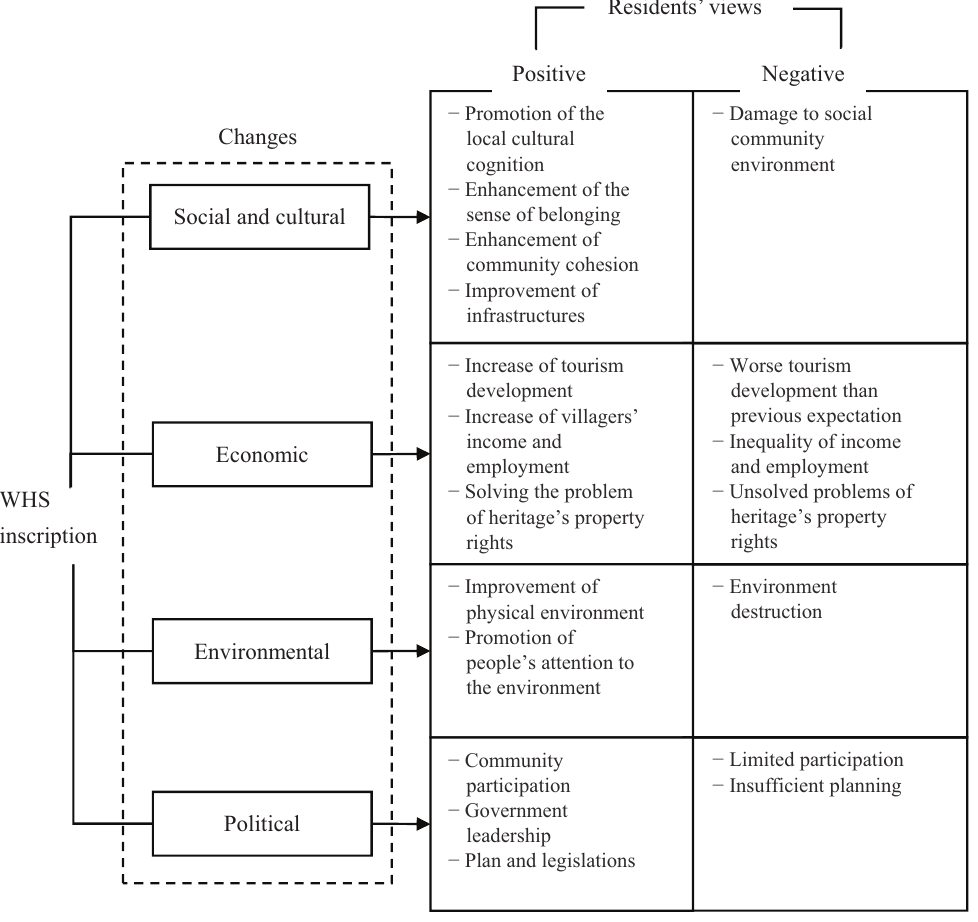
Figure 10. Present factors of the WHL inscription’s impacts on community of Kaiping Diaolou and